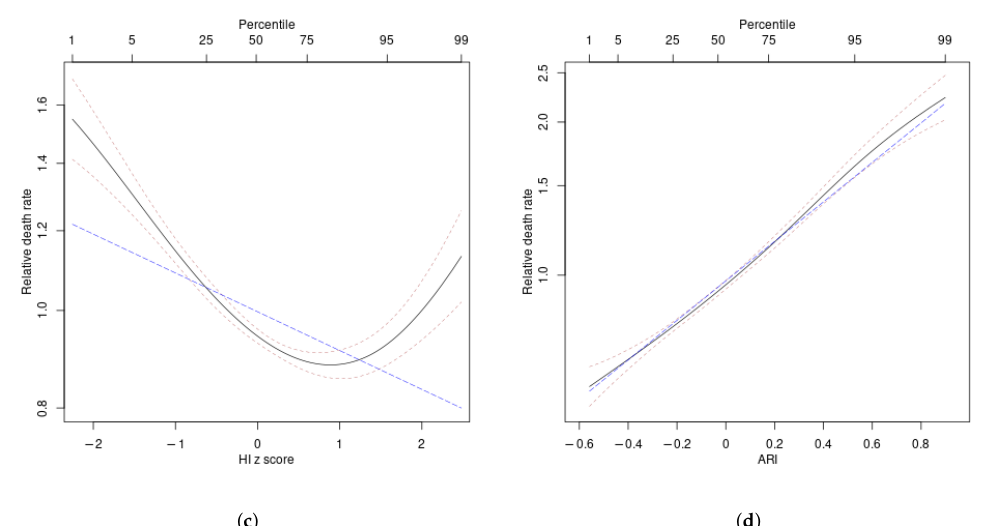
Figure 1. Estimated mortality hazard ratios in ARIC as nonlinear (penalized spline) functions of ( a ) BMI, ( b ) ABSI, ( c ) HI, ( d ) ARI (solid curves). Thin dashed curves indicate 95% confidence intervals. The blue long-dashed line shows the corresponding best linear fit, which can be seen in some cases to not capture well the underlying nonlinear relationship.